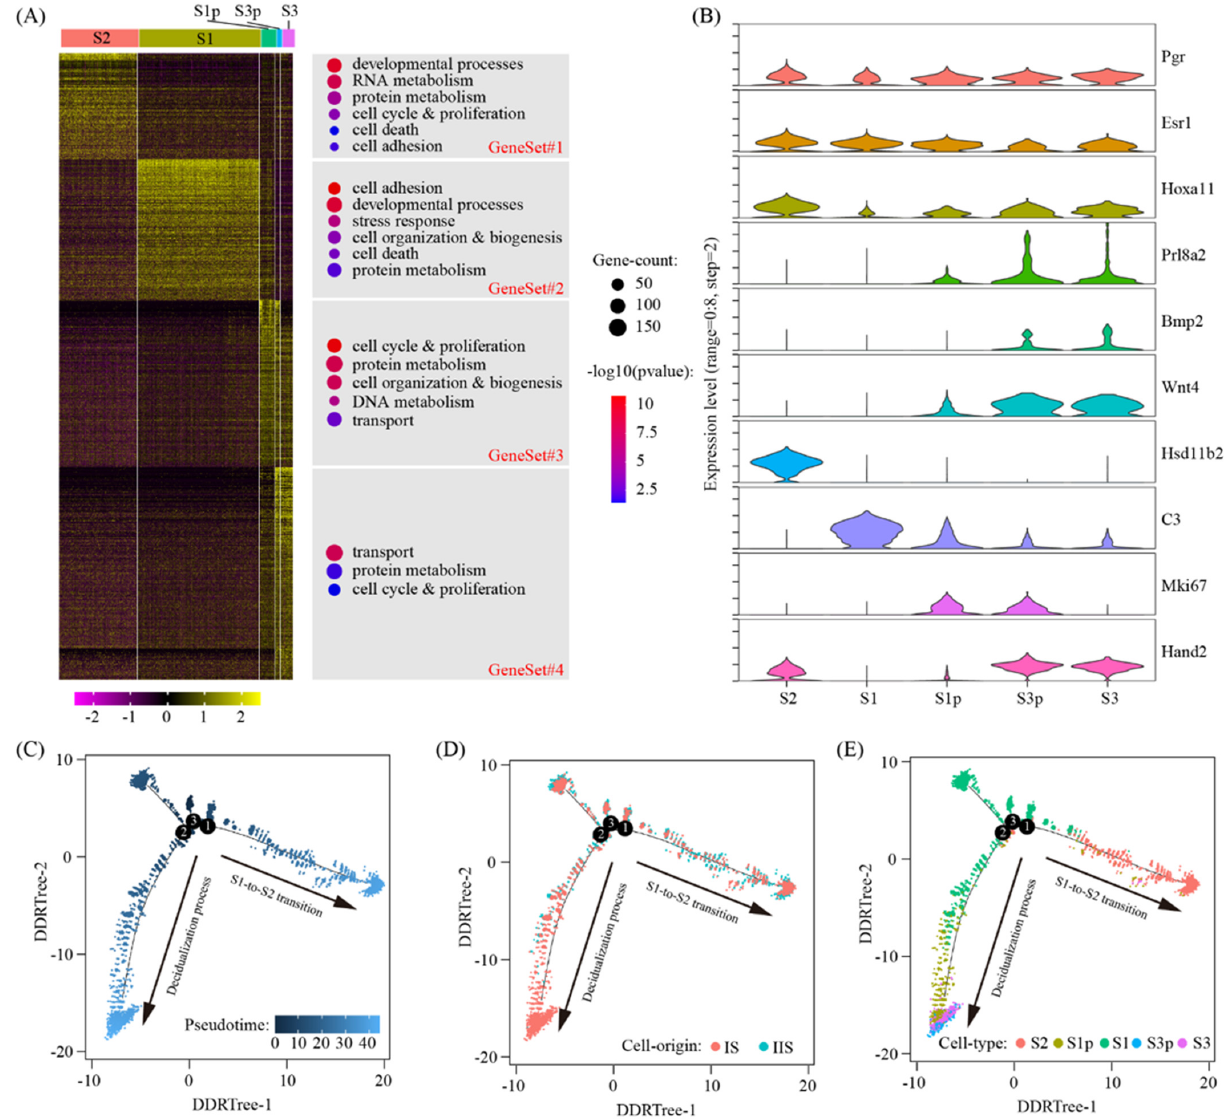
Figure 3. Sub-cluster analysis of stromal cells. ( A ) Heatmap of gene expression signatures for all stromal cell sub-clusters ( left ). All signature genes were divided into 4 gene sets and enriched gene ontology terms were assigned accordingly ( right ). ( B ) The expression pattern of marker genes for sub-clusters of stromal cells using violin plot. Shown were pan-stromal cell markers (Pgr, Esr1 and Hoxa11), decidual cell markers (Prl8a2, Wnt4 and Bmp2) and gene set reprehensive genes (Hsd11b2 for #1, C3 for #2, Mki67 for #3 and Hand2 for #4). ( C – E ) Pseudotime ordering of stromal cells. The distribution of pseudotime ( C ), cell origin ( D ) and cell type ( E ) across the reconstructed trajectory were displayed.